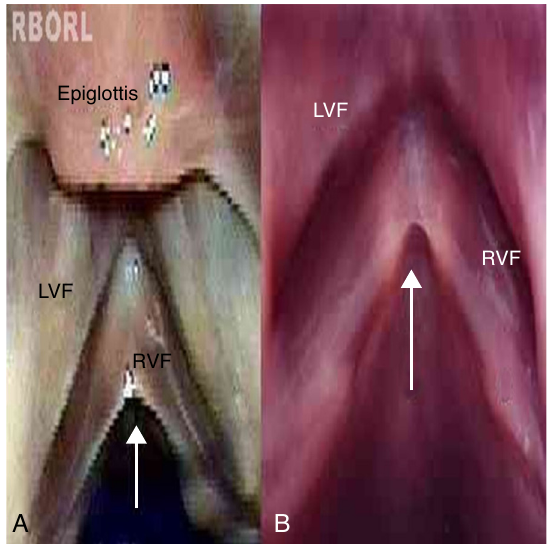
Laryngeal micro-diaphragm (arrow). (A) Shows lar- ynx 52, and (B) shows larynx 54. (LVF, left vestibular fold; RVF, right vocal